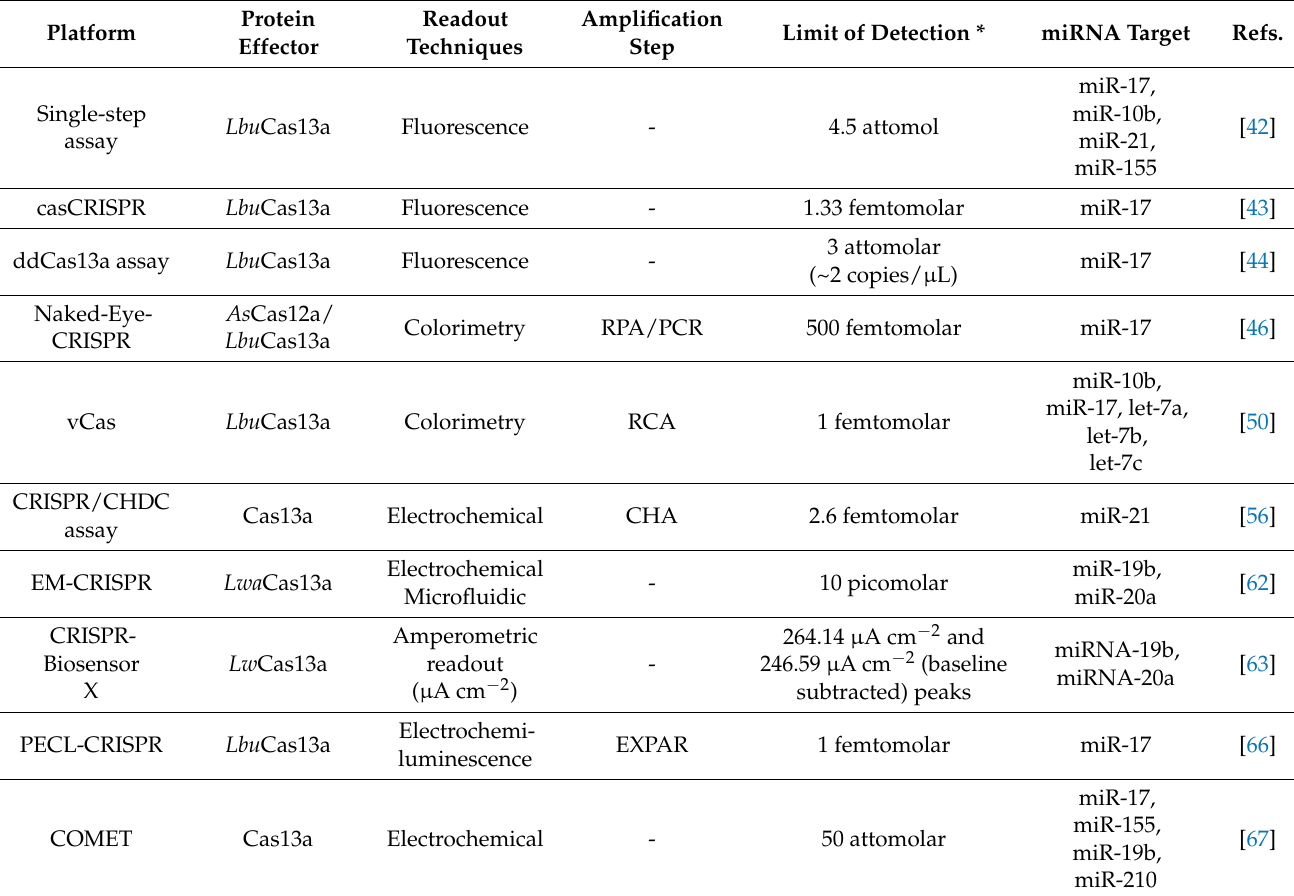
Table 2. Comparison of the CRISPR/Cas13-based biosensors for microRNA